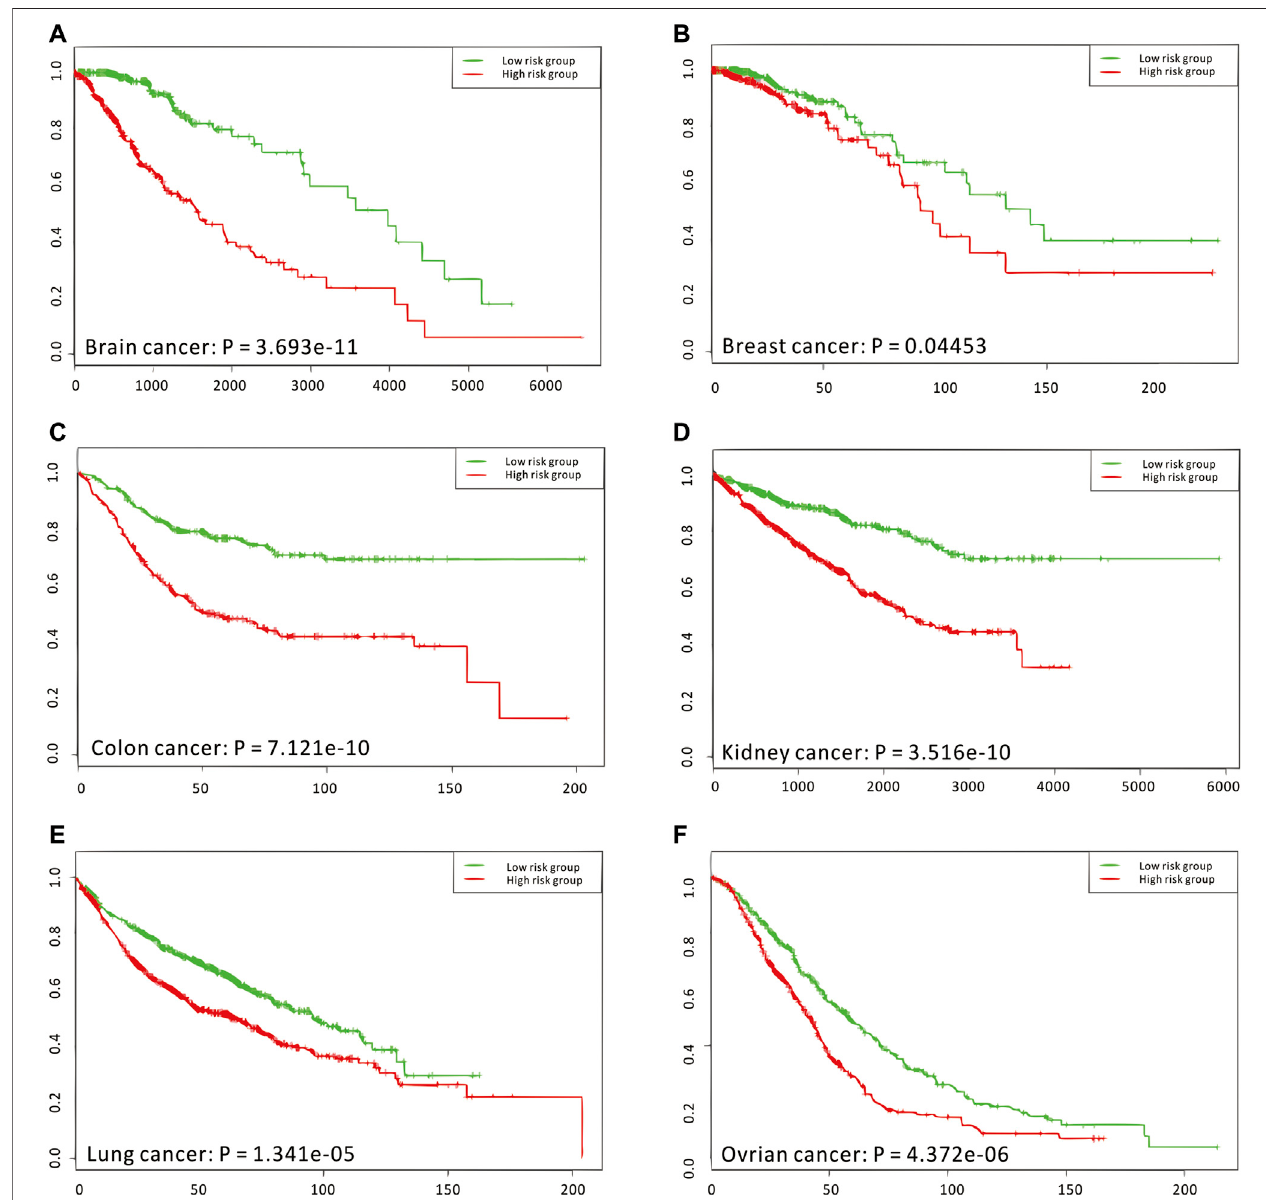
FIGURE6| IndependentsurvivalanalysesofnQTLmodulesfromthehumanPBMCdataset. (A – F) Thevalidation onbrain,breast,colon,kidney,lung,andovarian cancer, respectively. And these analysis results are obtained from the SurvExpress web server, where p -values are produced from the Cox model.